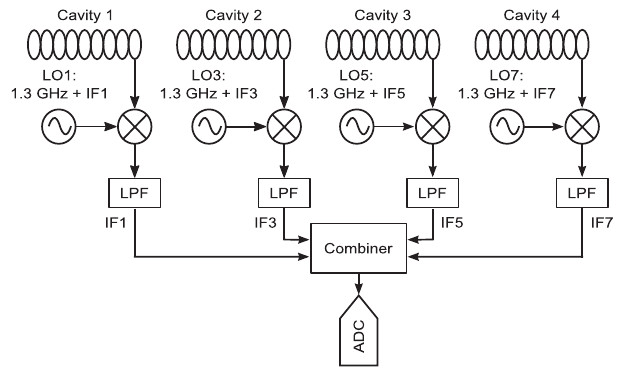
FIG. 5. Front-end of digital LLRF control system with four different IFs. Each cavity output is mixed with different LO frequencies and is then filtered by LPF. The four IFs are combined by a passive power combiner and its output is connected to one ADC.